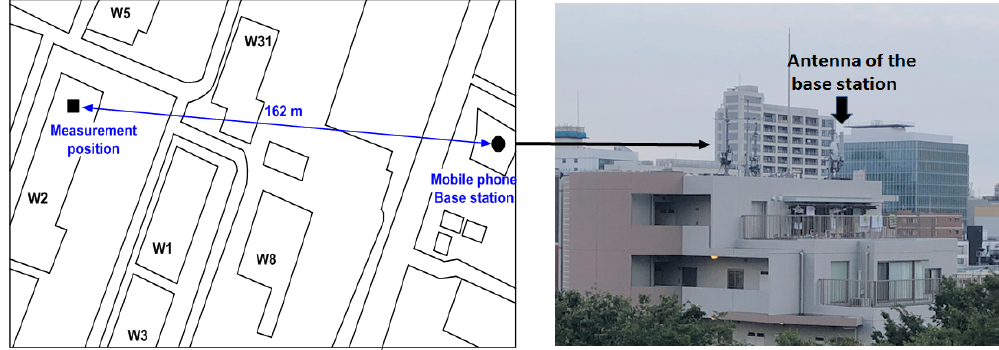
Figure 2. Map of the measurement position and picture of mobile phone